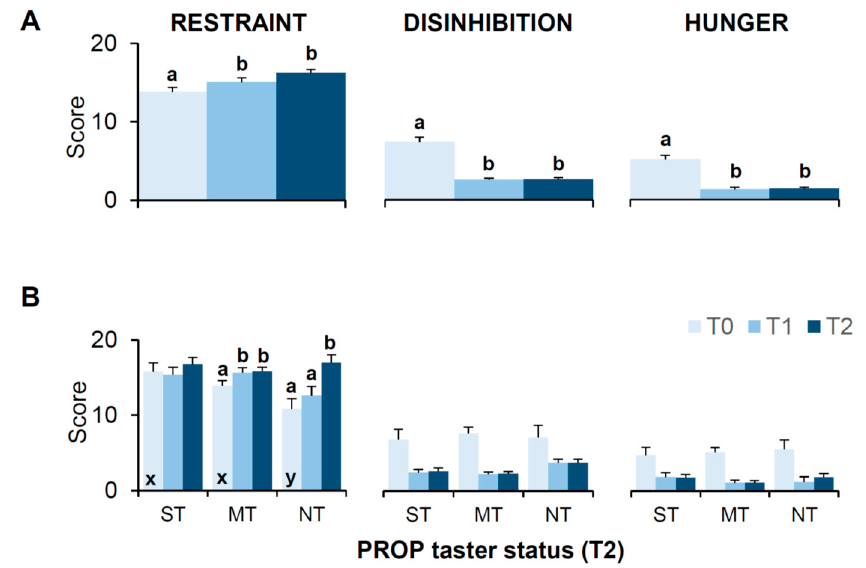
Figure 5. Mean ( ± SEM) values of the scores of the Three-Factor Eating Questionnaire (TFEQ) determined before (T0), one month (T1), and six months (T2) after bariatric surgery ( A ). The same data are shown for each PROP taster group determined at T2 (super-tasters: n = 11; medium tasters: n = 31; non-tasters: n = 9) ( B ). Significant differences are indicated by different letters: a and b are used to denote differences within sampling time (T0, T1 or T2), while x and y are used to denote differences with respect to the corresponding value of other groups. For all comparisons ( p ≤ 0.027, Fisher’s test LSD subsequent repeated measures ANOVA).